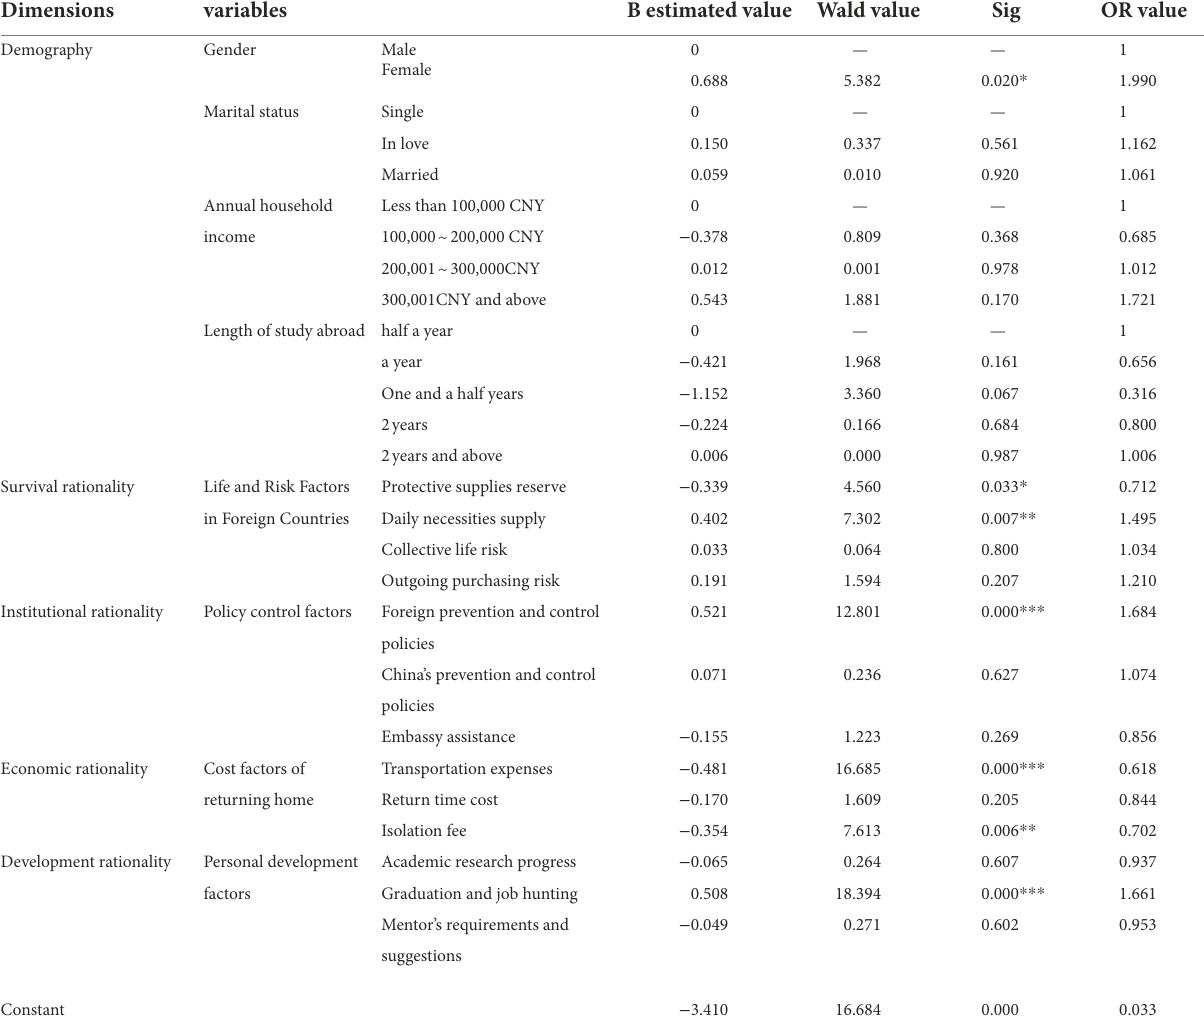
TABLE 6 Binary logistic regression analysis of influencing factors of overseas students’ choice of returning to China.